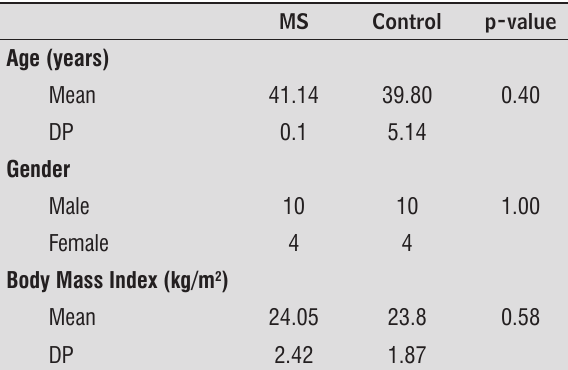
Table 1 - Profile of subjects